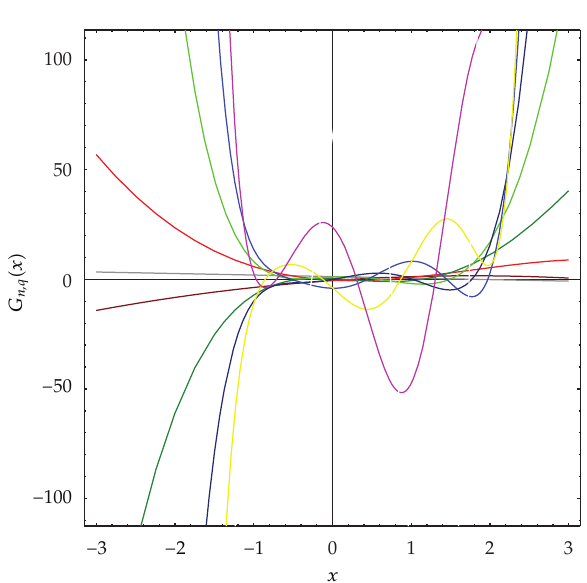
Figure 5: Curves of G n, 1 / 2 (cid:2) x (cid:3)